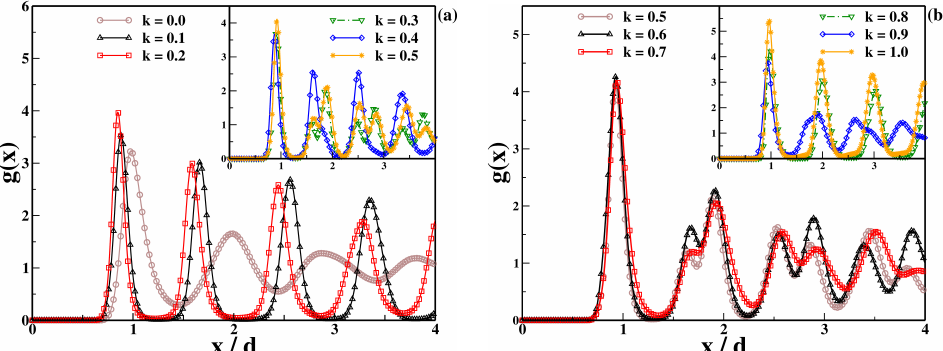
Figure 4. Pair distribution function along the x -direction for several values of the stiffness parameter: ( a ) 0 ≤ k ≤ 0.5 and ( b ) 0.5 ≤ k ≤